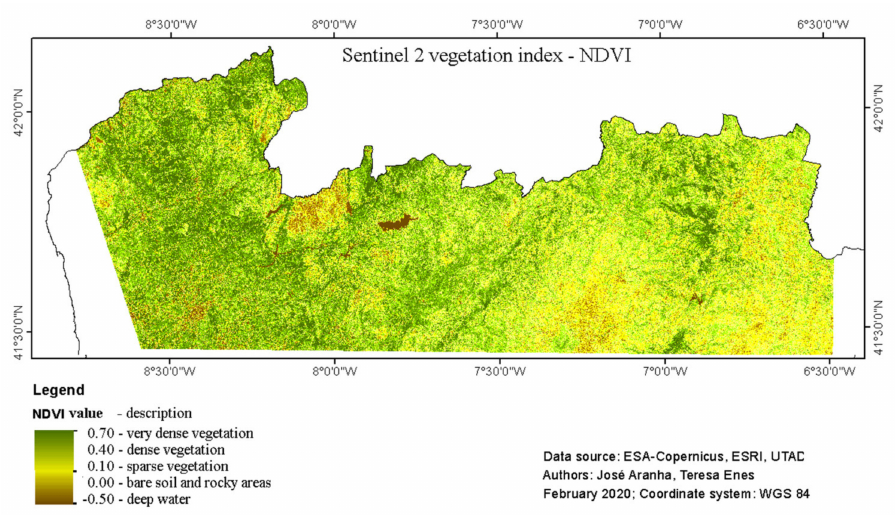
Figure 5. Sentinel 2 images (summer 2019) for the study area using an NDVI